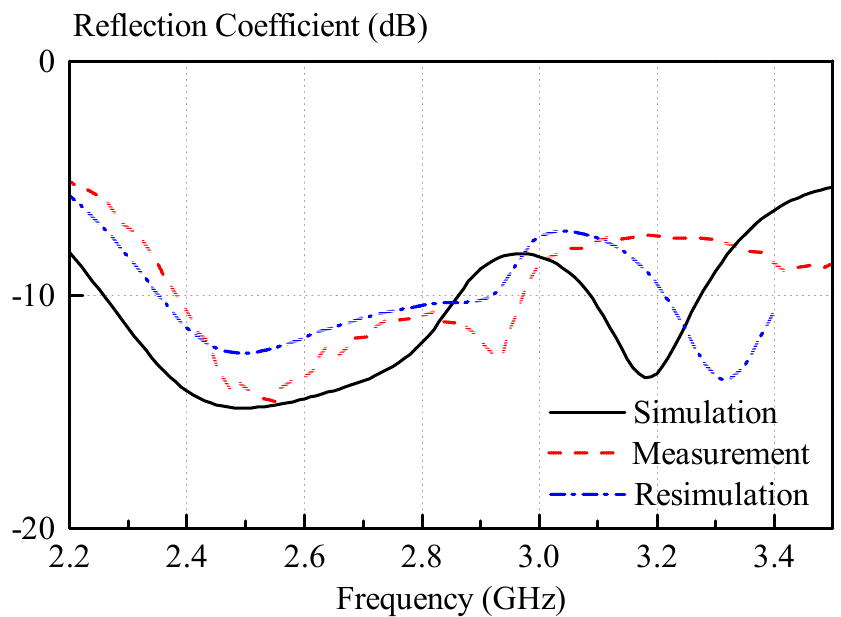
Figure 12. Measured and simulated reflection coefficients. The measured and simulated impedance bandwidth are 21.6% (2.39–2.97 GHz) and 23.4% (2.26–2.86 GHz). For the resimulation, the following values have been used: a = 24 mm, b = 24 mm, and a dielectric constant of the dielectric paste of ε r,paste = 9.5.